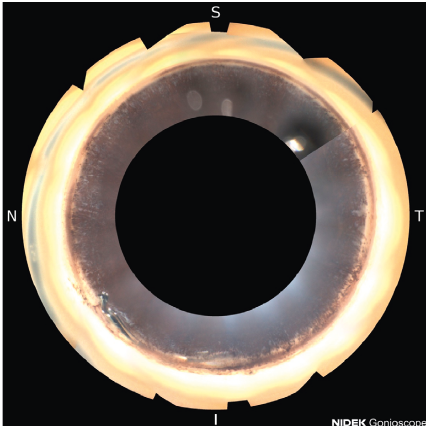
Figure 4: Extrusion of the distal tip of the Hydrus stent from Schlemm’s canal.